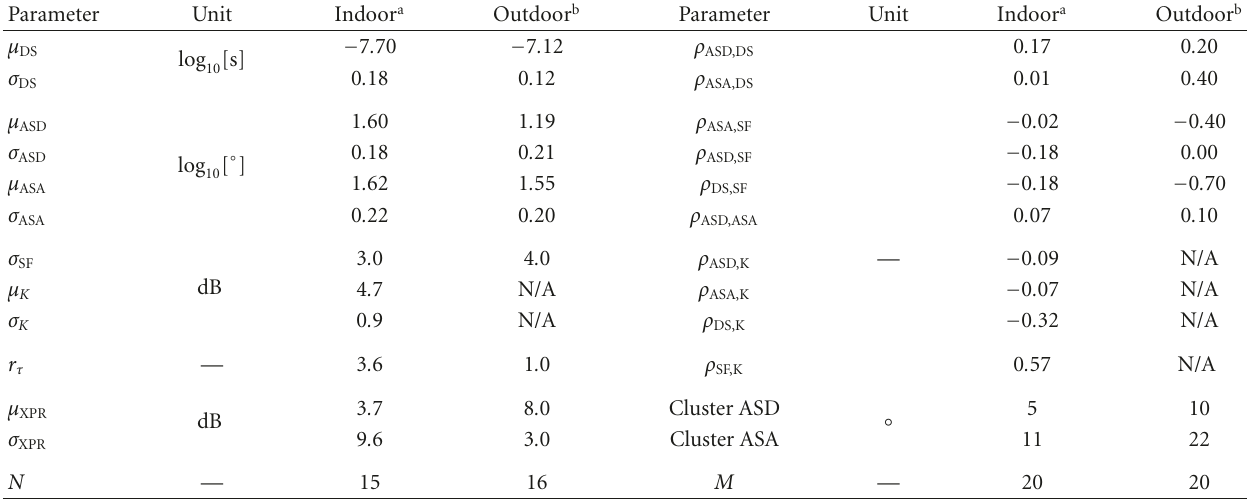
Table 3: Parameters for the baseline channel